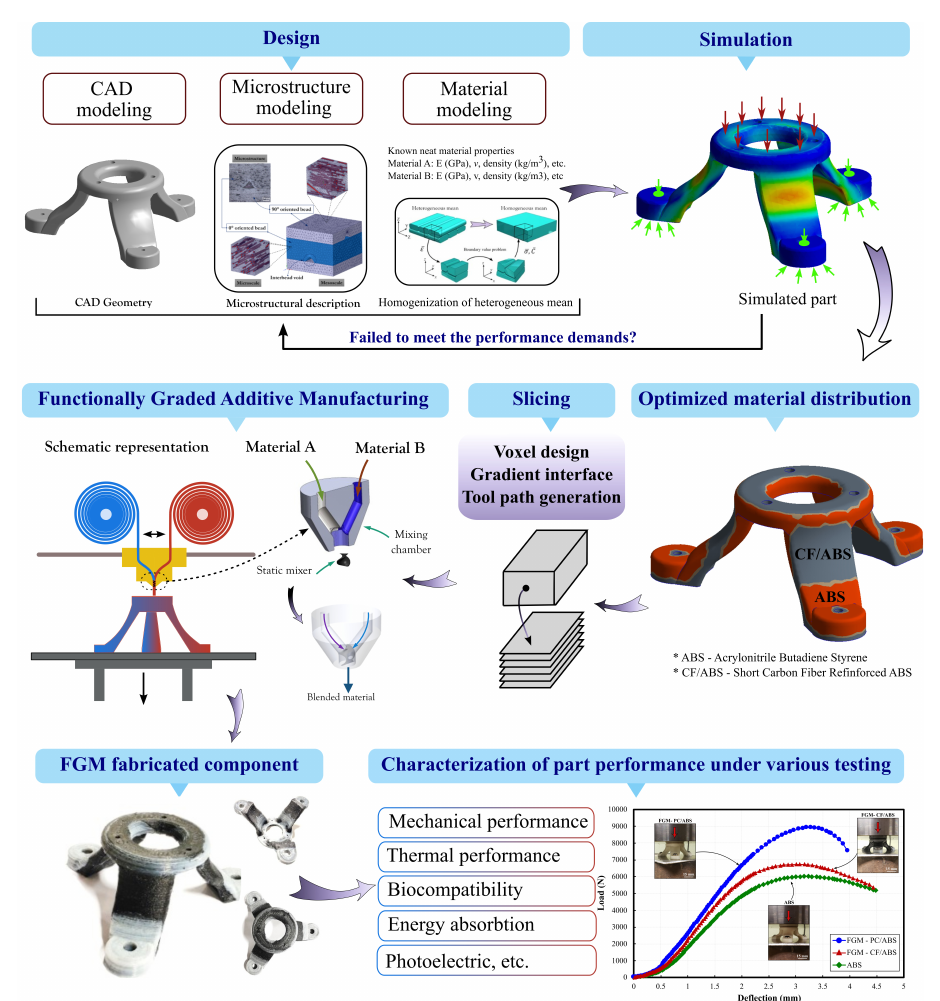
Figure 12. Functionally graded additive manufacturing workflow